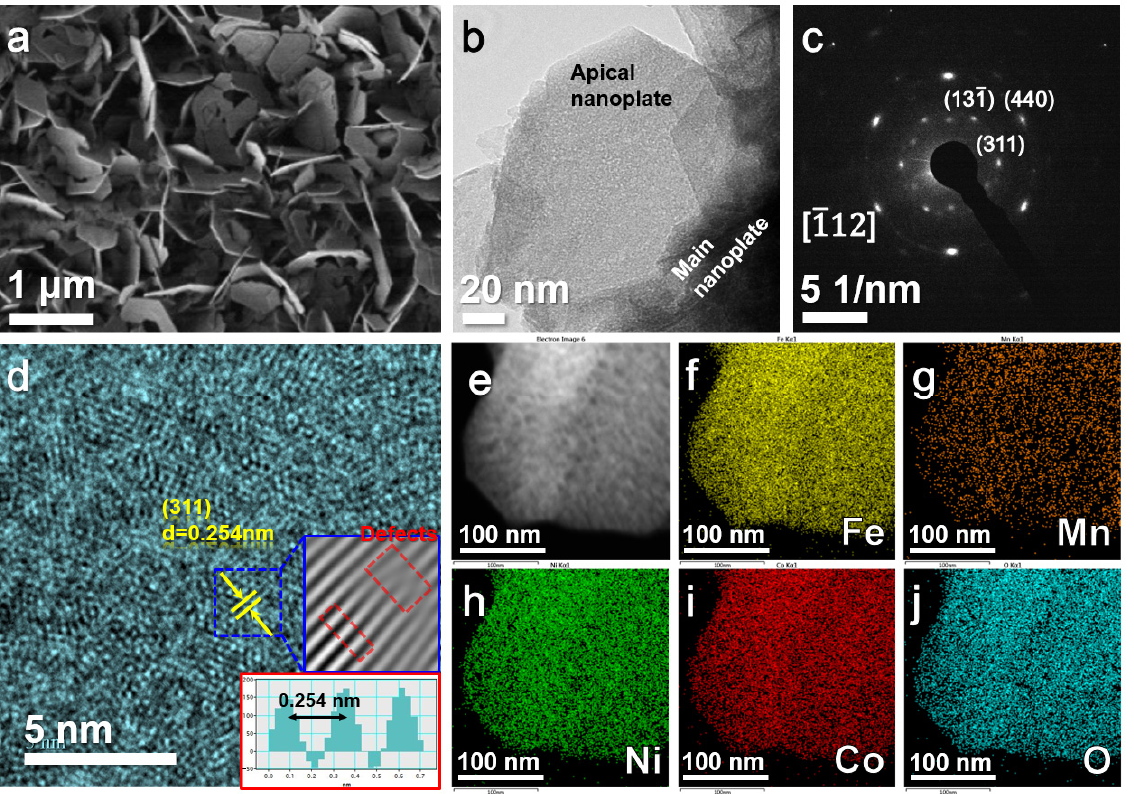
Figure 2. ( a ) SEM image, ( b ) TEM image, ( c ) SAED patterns, ( d ) HRTEM image and ( e – j ) EDS elemental mappings of as-prepared (Ni,Co,Mn)Fe 2 O 4 − x material.